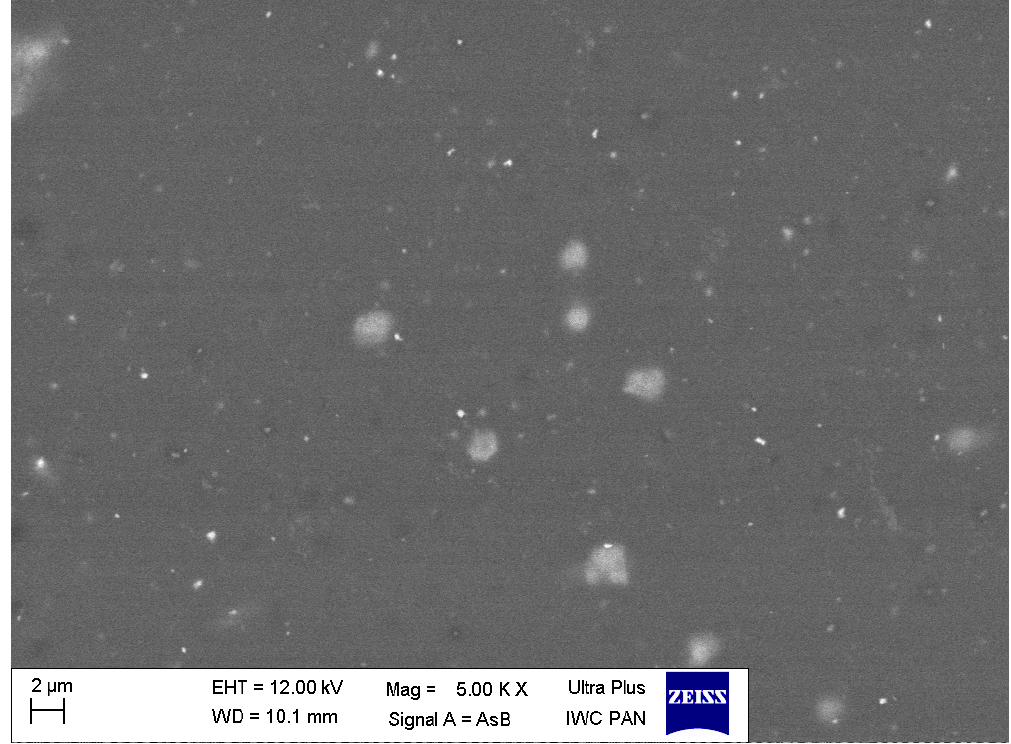
Figure 8. Representative SEM image of the nanocomposite (TiO 2 NPs Cp = 2